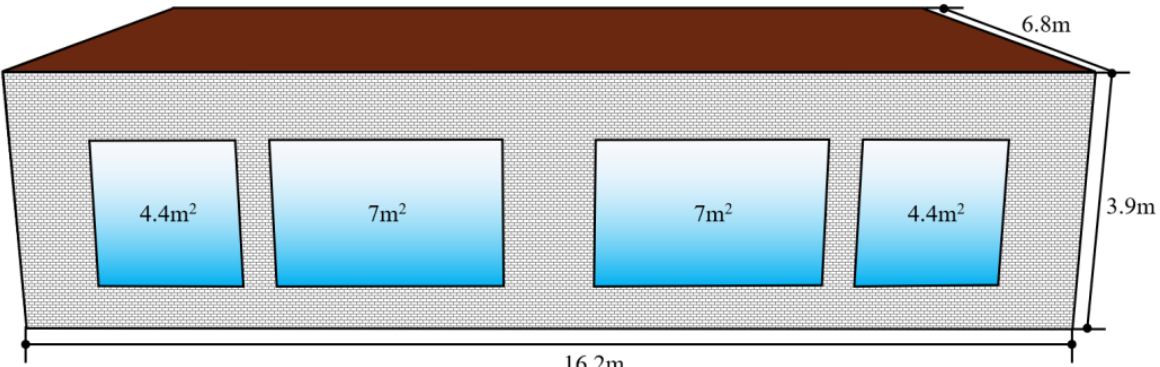
Figure 3. Operation strategies during the cooling season.